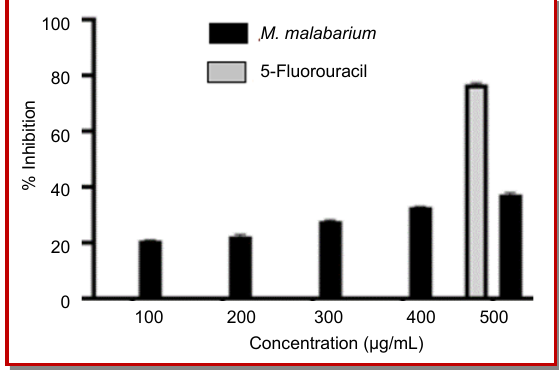
Figure 1: Antiproliferative activity of methanolic extract Me-